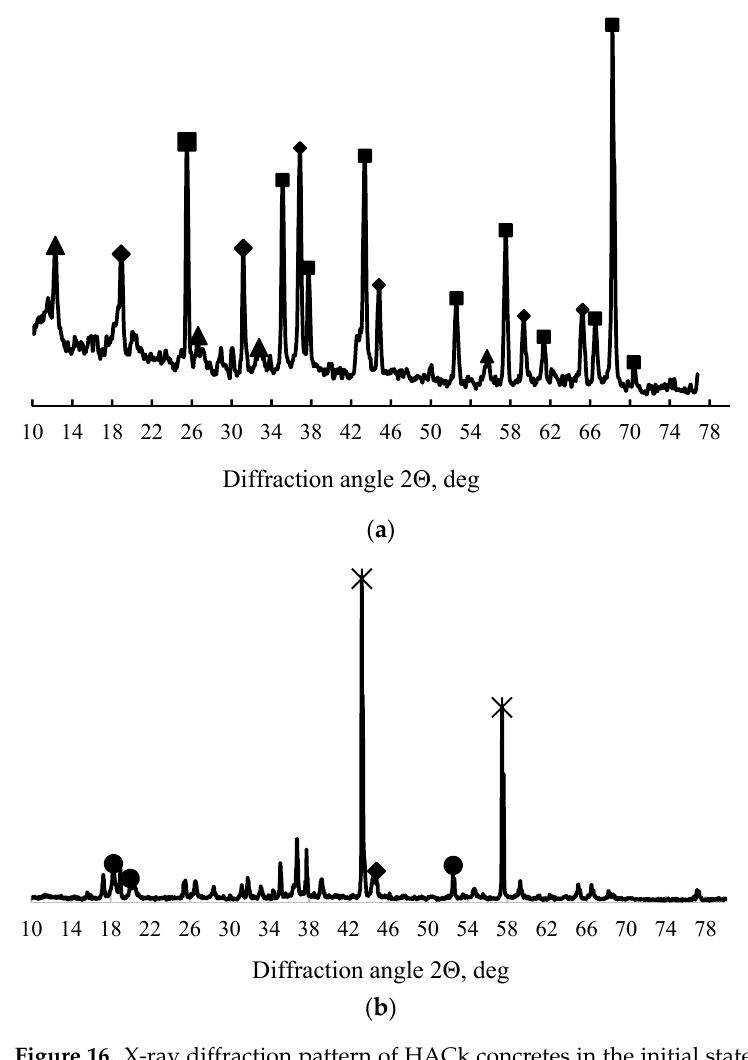
Figure 16. X-ray di ff raction pa tt ern of HACk concretes in the initial state ( a ) and after irradiation Figure 16. X-ray diffraction pattern of HACk concretes in the initial state ( a ) and after irradiation ( b ): Δ = Fe 2 O 3 (PDF card 000-33-0664); ■ = Al 2 O 3 (PDF card 000-42-1468); ♦ = MgAl 2 O 4 (PDF card 000- ( b ): ∆ = Fe 2 O 3 (PDF card 000-33-0664); (cid:4) = Al 2 O 3 (PDF card 000-42-1468); (cid:7) = MgAl 2 O 4 (PDF card 21-1152); ▲ = CaAl 2 O 4 10H 2 O (PDF card 000-11-0204); ● = Al(OH) 3 (PDF card 000-12-0460); x = 000-21-1152); (cid:78) = CaAl 2 O 4 10H 2 O (PDF card 000-11-0204); • = Al(OH) 3 (PDF card 000-12-0460); Ca 3 Al 2 (OH) 12 katoite (PDF card 000-24-0217). Ж = Ca 3 Al 2 (OH) 12 katoite (PDF card